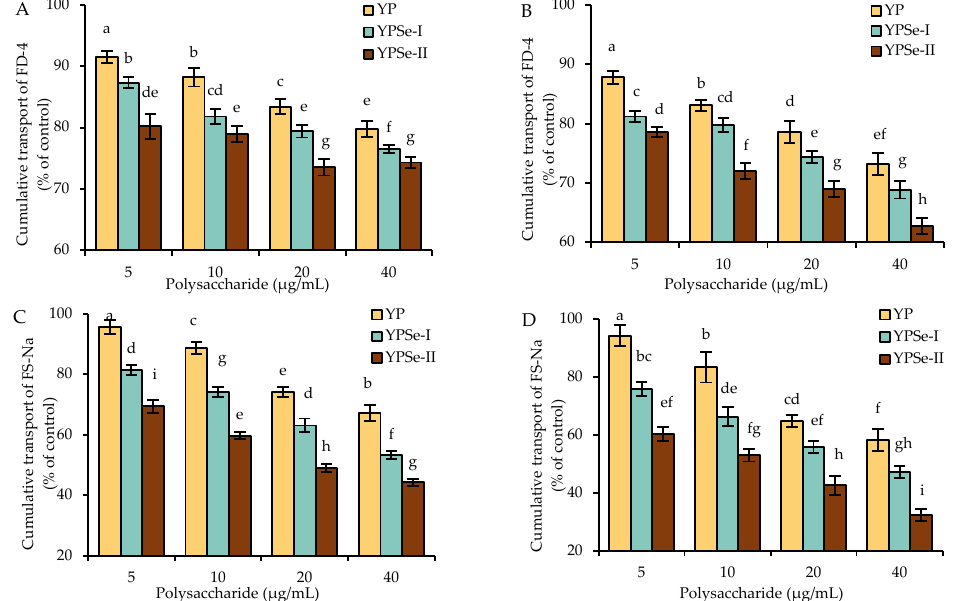
Figure 3. Diffusion of FD-4 and FS-Na in IEC-6 cells treated with YP, YPSe-I, and YPSe-II for 12 ( A , C ) or 24 h ( B , D ). Different lowercase letters above the columns denote a significant difference in the one-way ANOVA means ( p < 0.05).